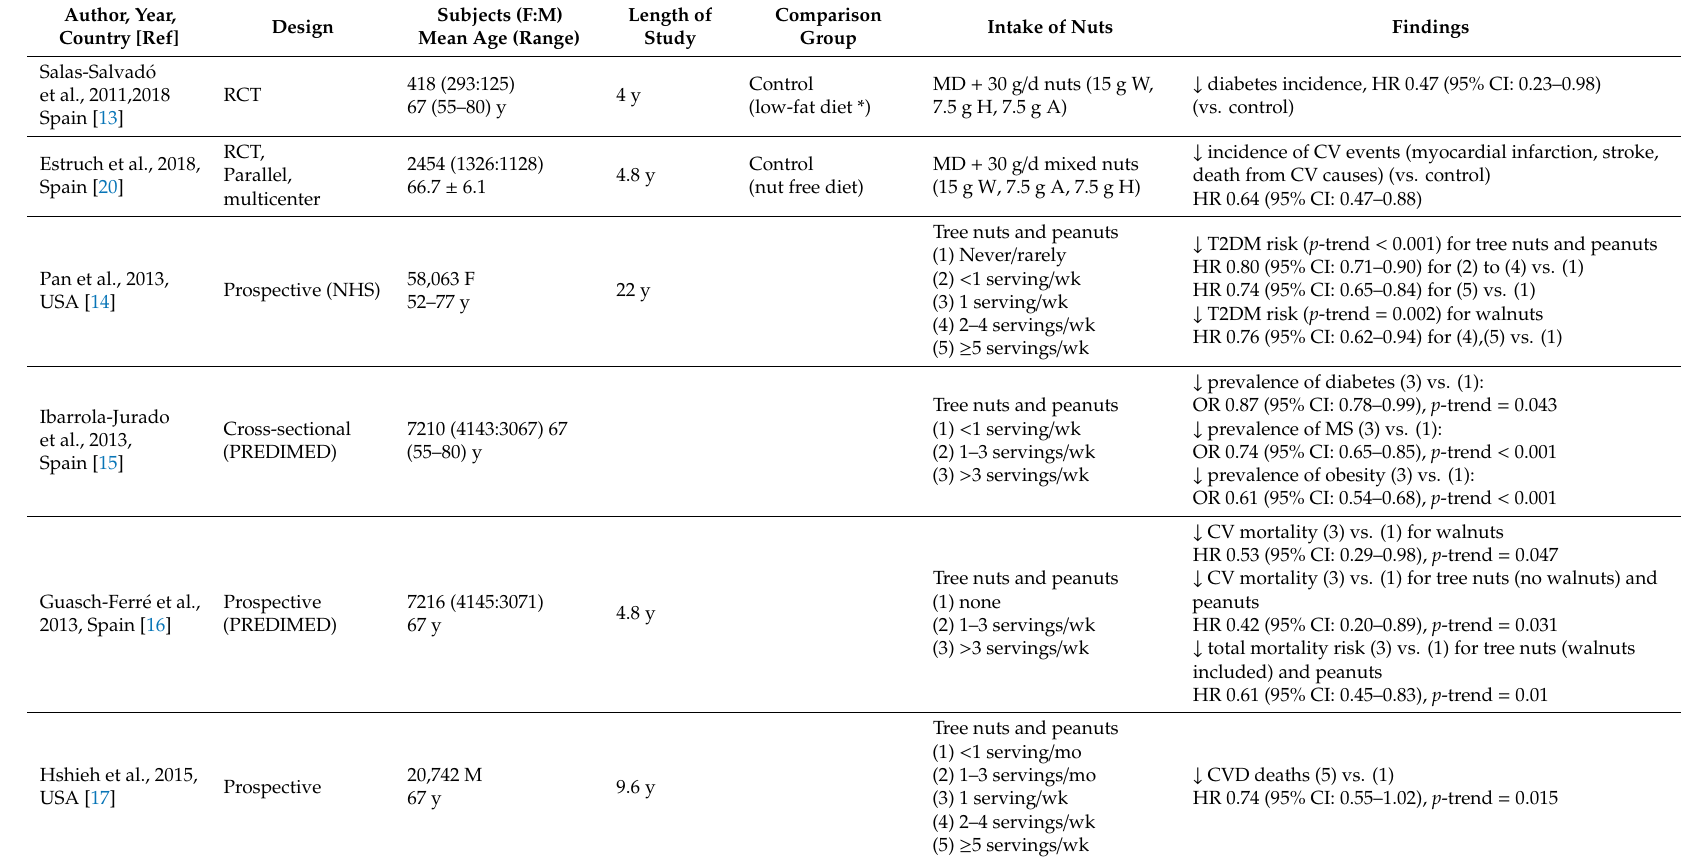
Table 1. Nut consumption and cardiometabolic morbidity and